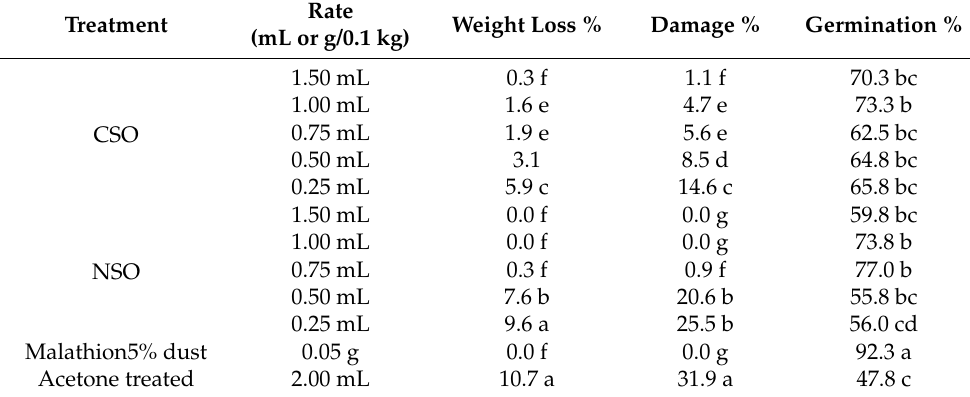
Table 4. Effect of NSO and CSO on weight loss, damage, and germination.